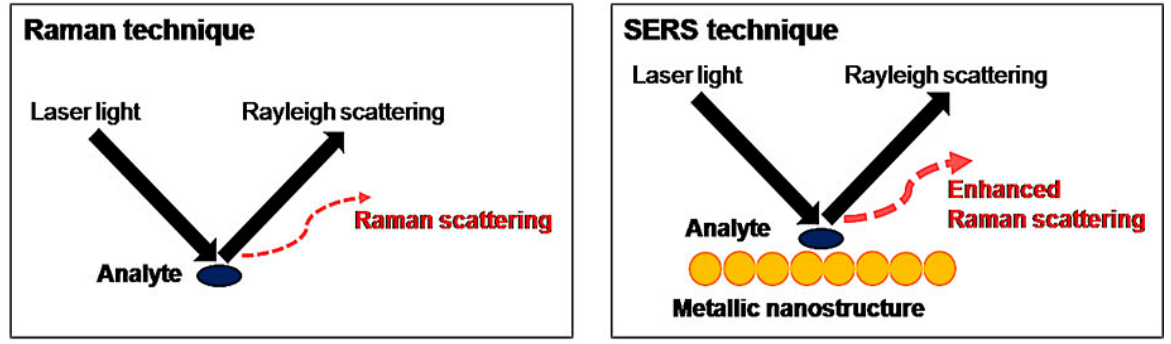
Figure 6. The principles behind Raman and SERS techniques